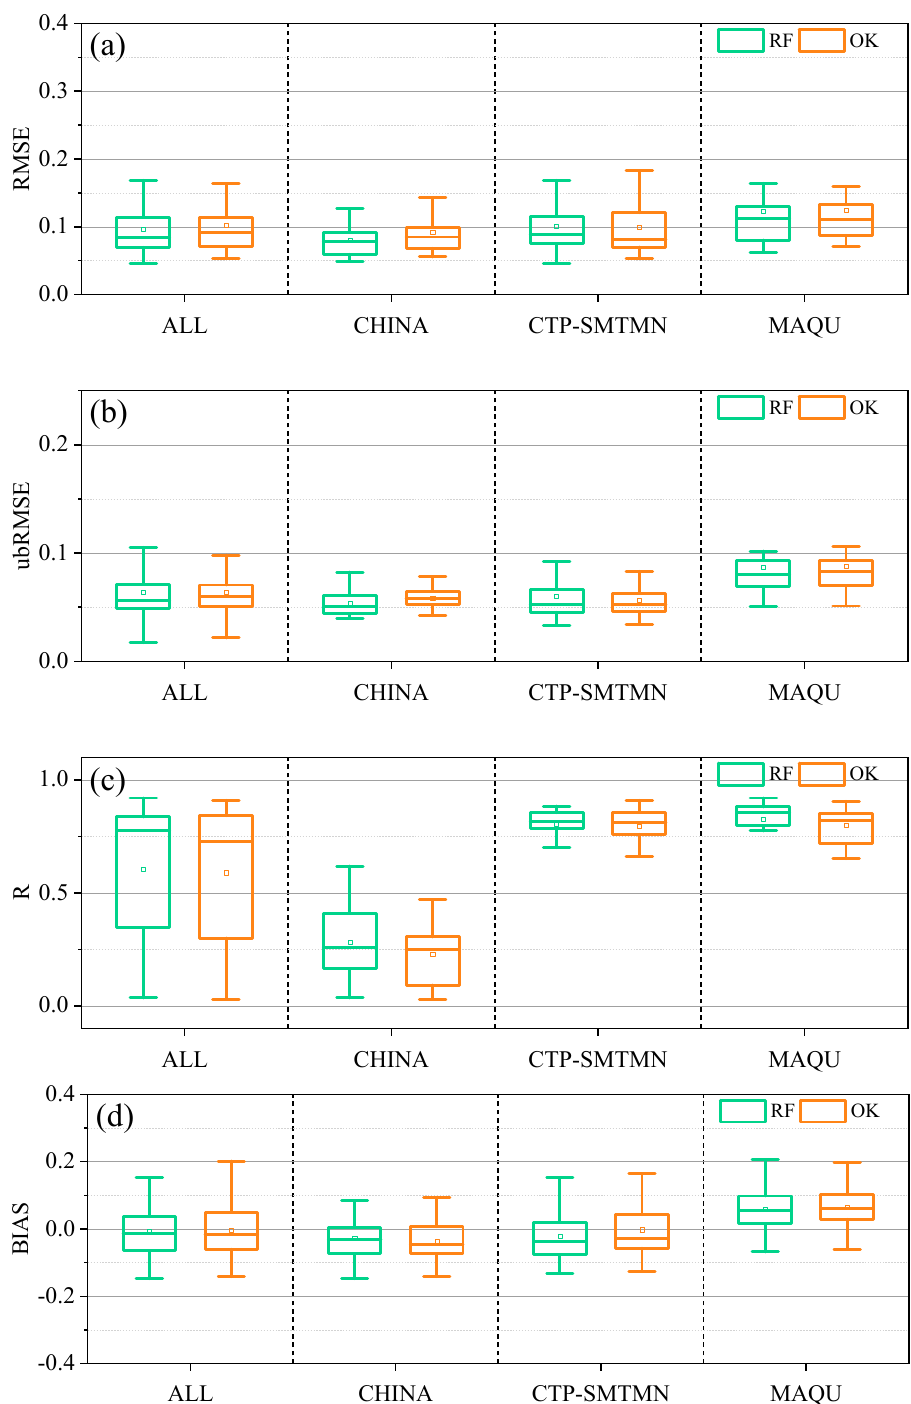
Figure 8. Comparisons between in situ SM and estimated SM at each network (CHINA, CTP- SMTMN, MAQU) and all networks (ALL) with evaluation indicators of ( a ) RMSE, ( b ) ubRMSE, ( c ) R, and ( d ) BIAS.